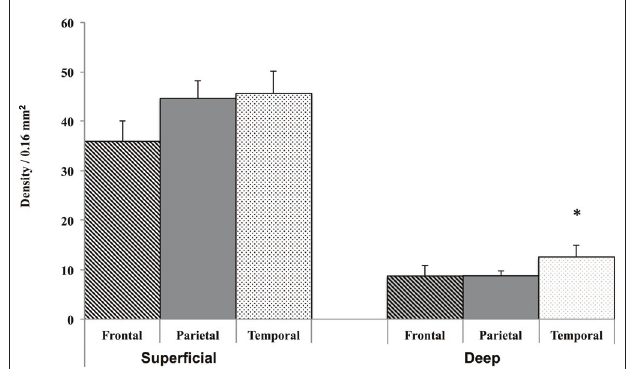
FIGURE 5 | Grouped data from young and old monkeys (n = 8) only showed a significant difference for the density of WMNs in the deep strata in TE, but not for those in FR and Par, nor for superficial WMNs in any of the other regions . ∗ p < 0.05, compared to all